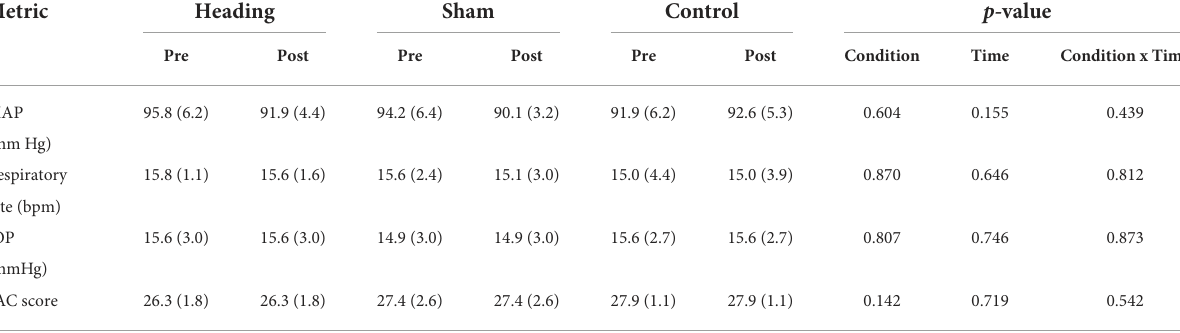
TABLE 1 Resting physiologic parameters and Standardized Assessment of Concussion recorded before and after heading, sham, and control exposures. Metric